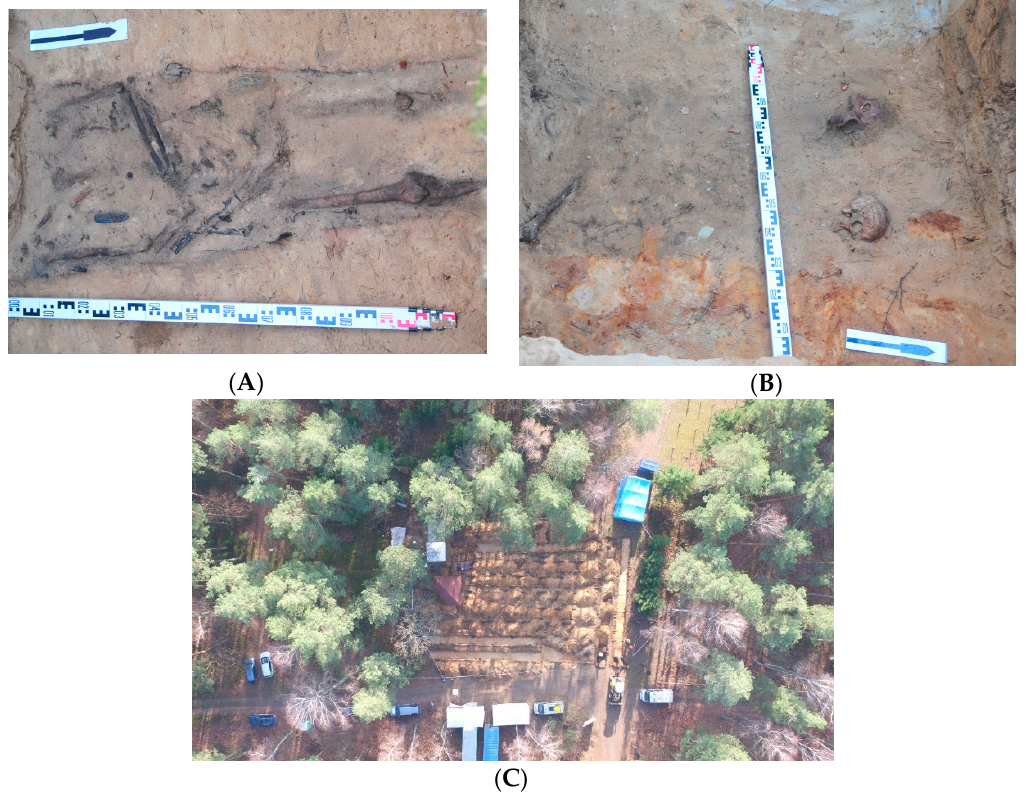
Figure 13. Photos of stratigraphic surveys: ( A ) no. 4 trench excavation; photo: S. Ró ż ycki; ( B ) no. 5 trench excavation; photo: S. Ró ż ycki; ( C ) aerial view of no. 6 trench excavation area; photo: A. Ossowski.